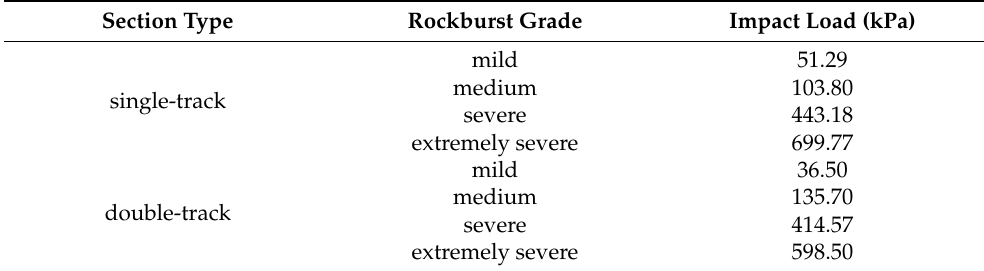
Table 13. Impact load calculation table.